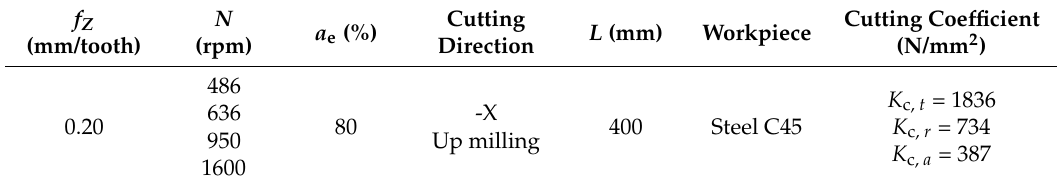
Table 4. Process conditions for steel C45 machining.